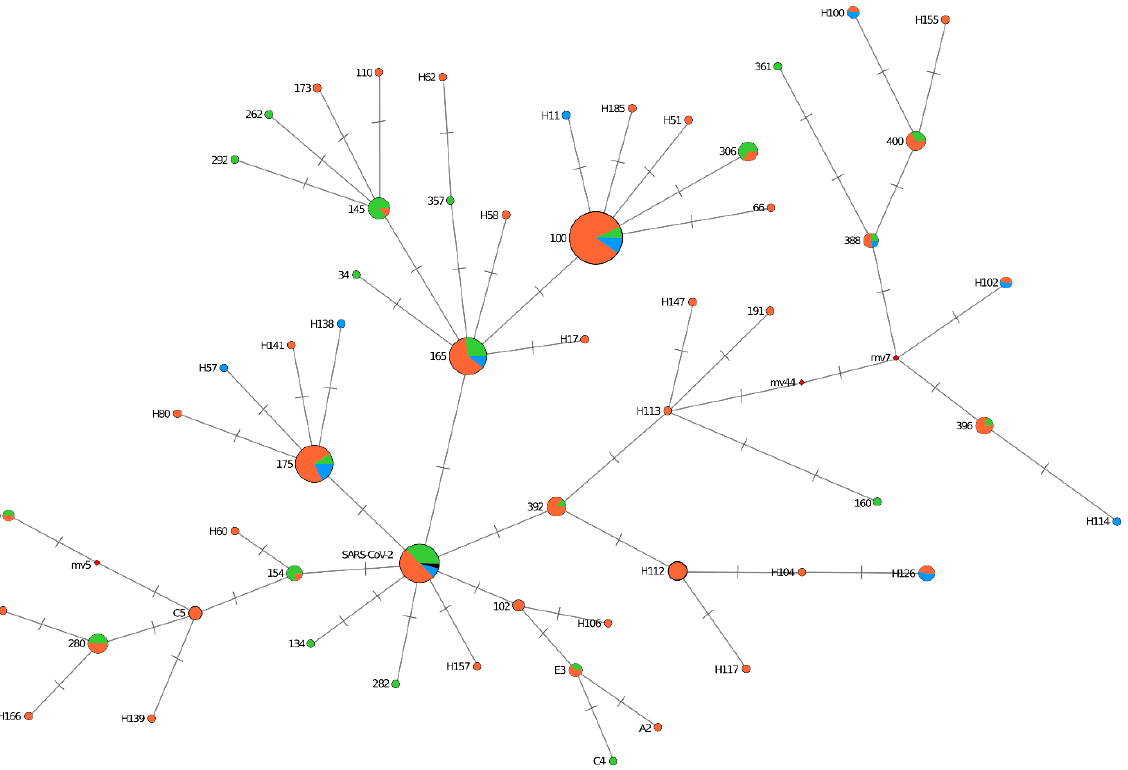
Figure 5. Phylogenetic network of SARS-CoV-2 Omicron BA.1 S gene sequences. Circle areas are proportional to the number of taxa, whereas each tick on the links represents a mutated nucleotide position. The median-joining network algorithm (epsilon parameter set to 10) was employed. Clusters are named by one of the sequences forming it. The node pie chart coloring illustrates the proportion of each group in the node. Key: strains introduced to St. Petersburg by Pulkovo Airport arrivals — green; strains from outpatients — orange; strains from inpatients — blue; and South African reference strain (EPI_ISL_6913991) — black.